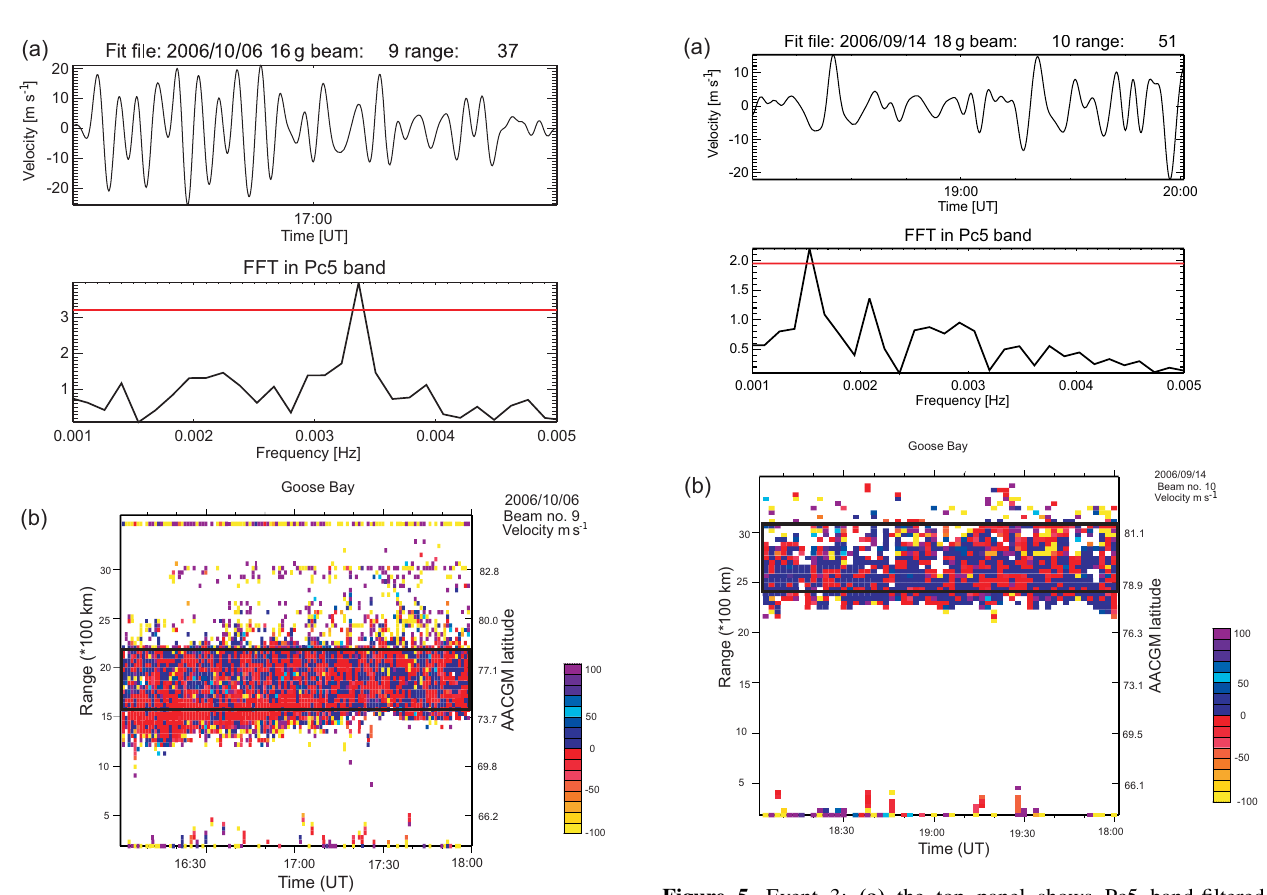
Figure 4. Event 2: (a) the top panel shows Pc5 band-filtered Doppler velocity data from the Goose Bay radar. The lower panel contains the corresponding power spectrum together with the sig- nificant limit level from filtered data. The peak detector recorded the peak in frequency band 3.2–3.5mHz as significant. (b) A time– range summary plot of Doppler velocity in metres per second mea- sured by beam 9 of Goose Bay radar showing range and AACGM latitude.